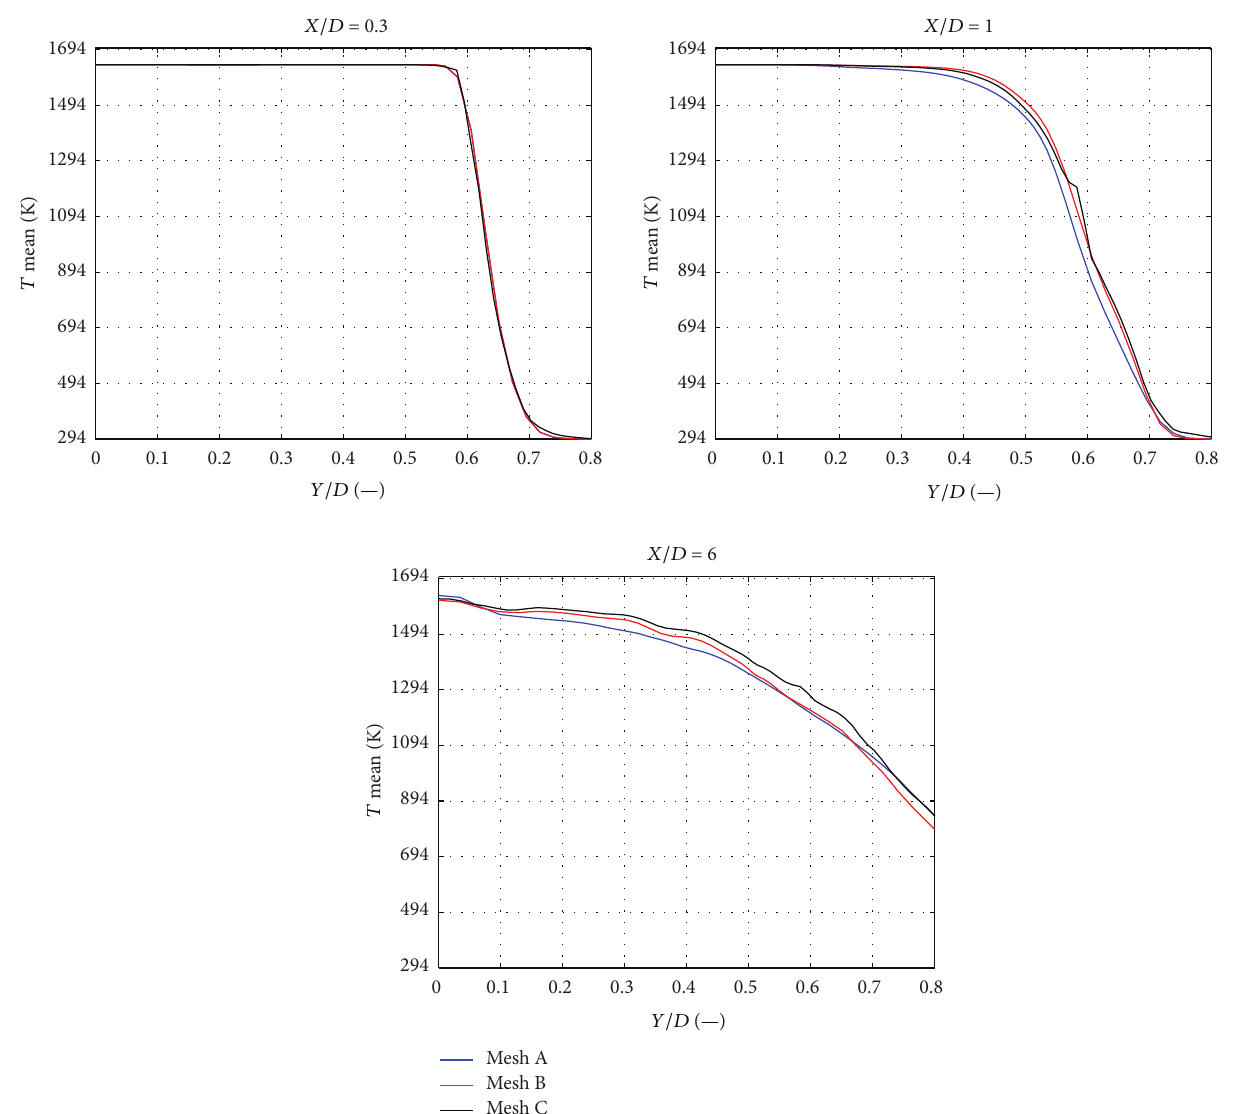
Figure 3: Mean temperature profiles resulting from mesh size sensitivity